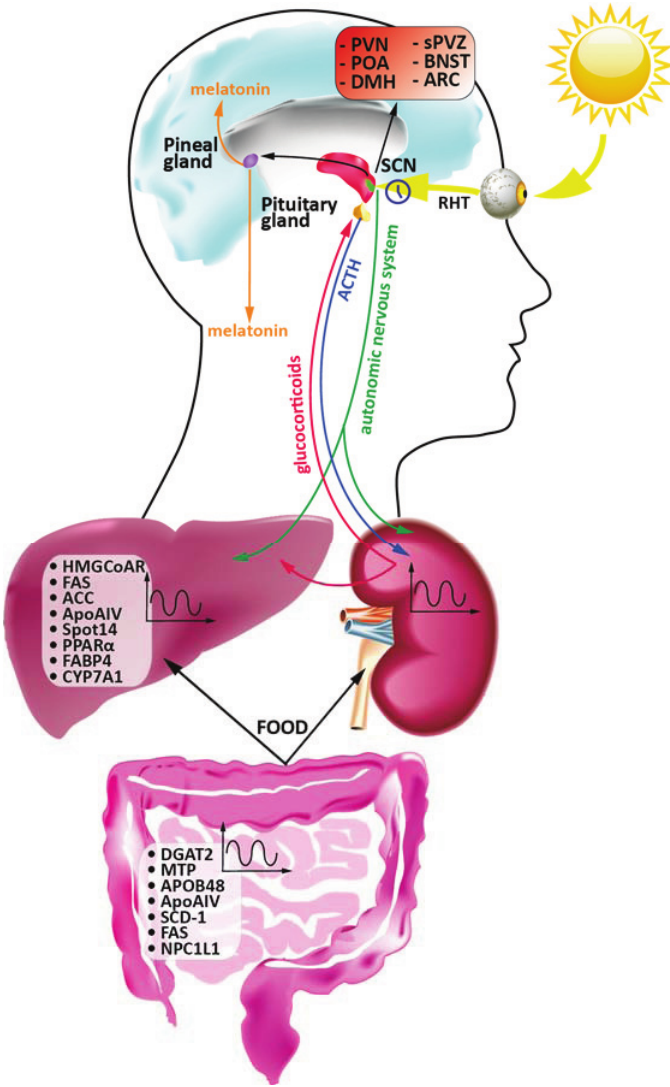
Figure 2. Schematic overview of the interplay between the central and peripheral